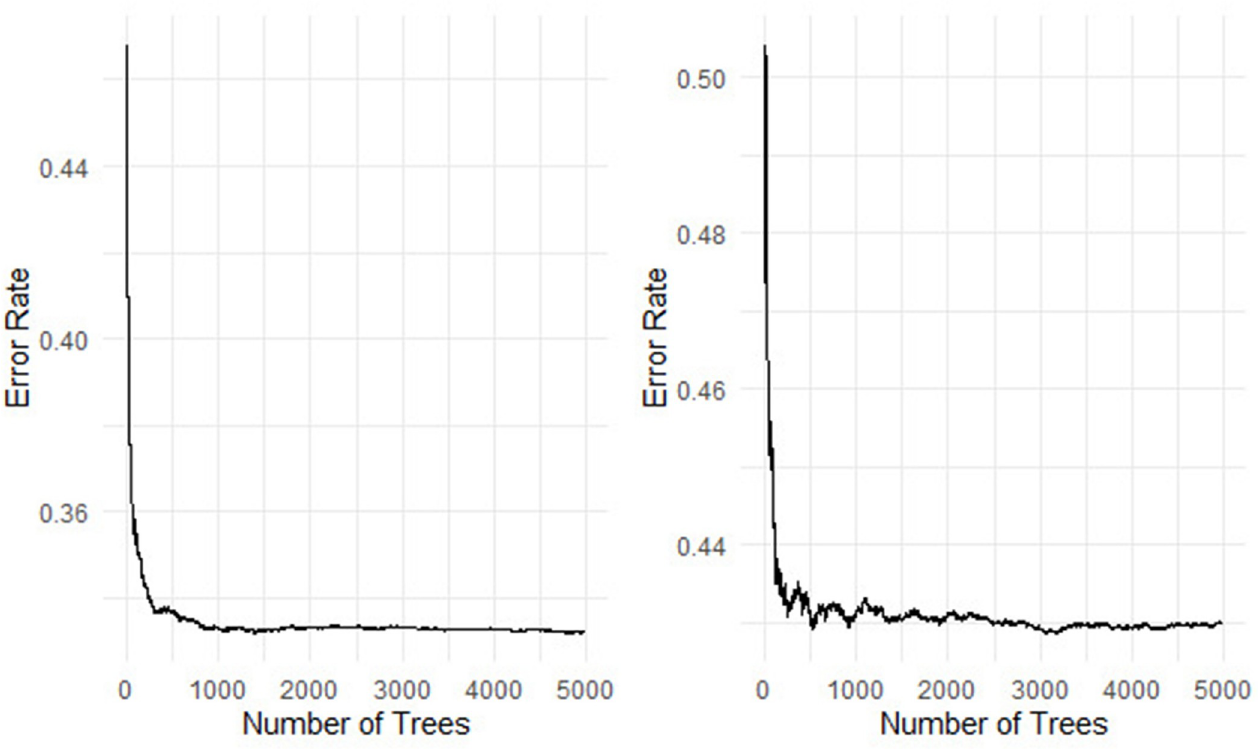
Fig 4. The prediction error rate for random survival forests of 5000 trees after imputation and the log-rank and log-rank-score in the left and right panel, respectively, using 80% training dataset.